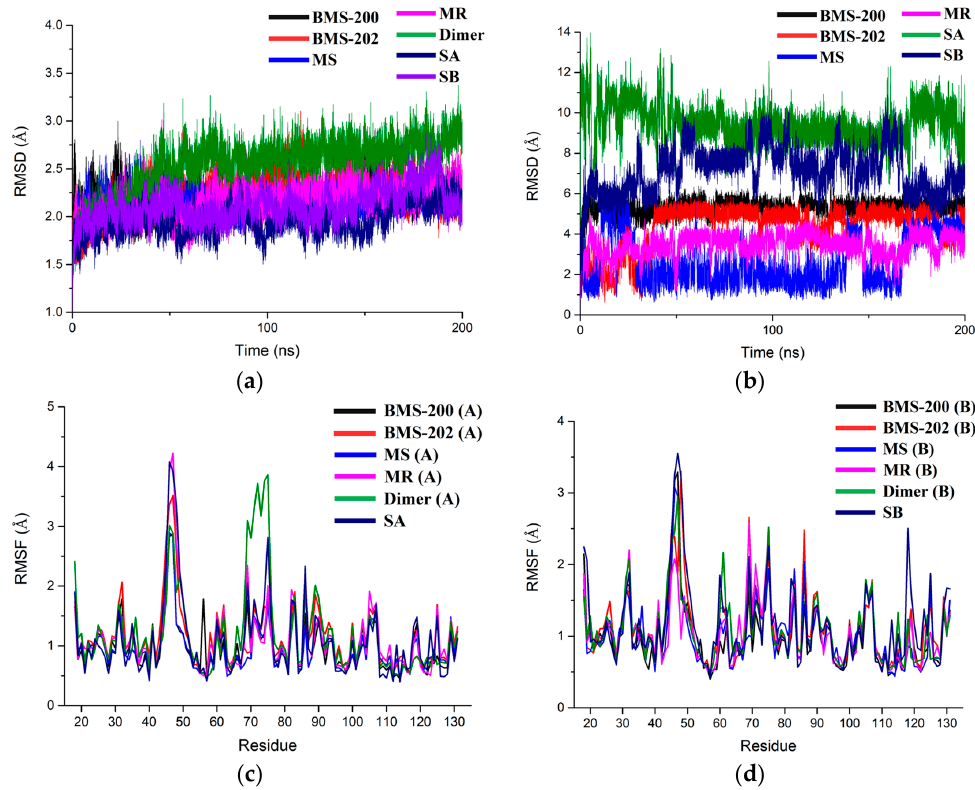
Figure 4. The RMSD and RMSF plots of all the systems during 200 ns MD simulation. ( a ) RMSD of protein heavy atoms. ( b ) RMSD of the inhibitors atoms. ( c ) RMSF of A PD-L1 residues. ( d ) RMSF of B PD-L1 residues.